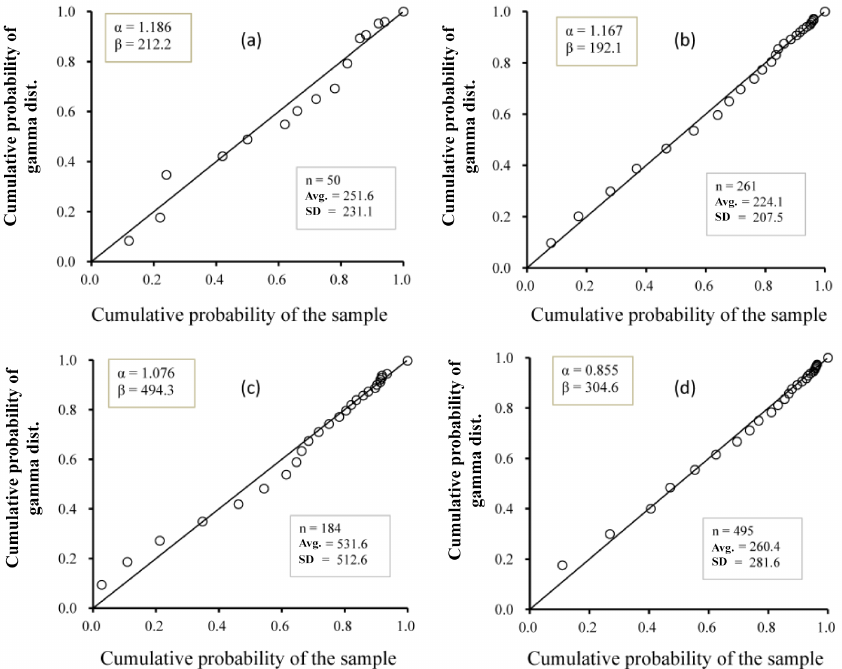
Figure 4. P-P plots of the cumulative probability of the measured methane fluxes vs. the gamma distribution. (a) Single-drainage irrigation cases, (b) multi-drainage irrigation cases, (c) continuous flooding irrigation cases, and (d) all cases after being area weighted (Sect. S1). n , avg., and SD represent the sample size, statistical mean, and standard deviation of the sample methane fluxes, respectively. α and β represent the shape and scale parameters of the gamma distribution, which were calculated with the statistical mean and variance of the measured methane fluxes; β = ( SD ) 2 /( avg. ) and α = ( avg .)/β . The diagonal line is the 1:1 straight line for a perfect gamma distribution match.